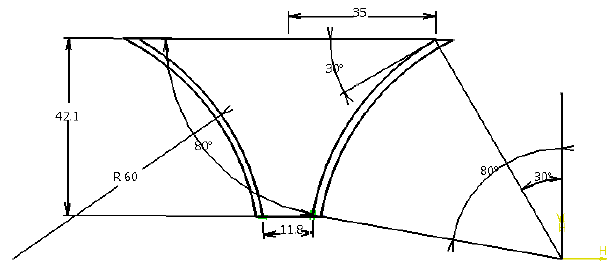
Figure 7. Geometric illustration of the truncated cone profile (dimension in mm).